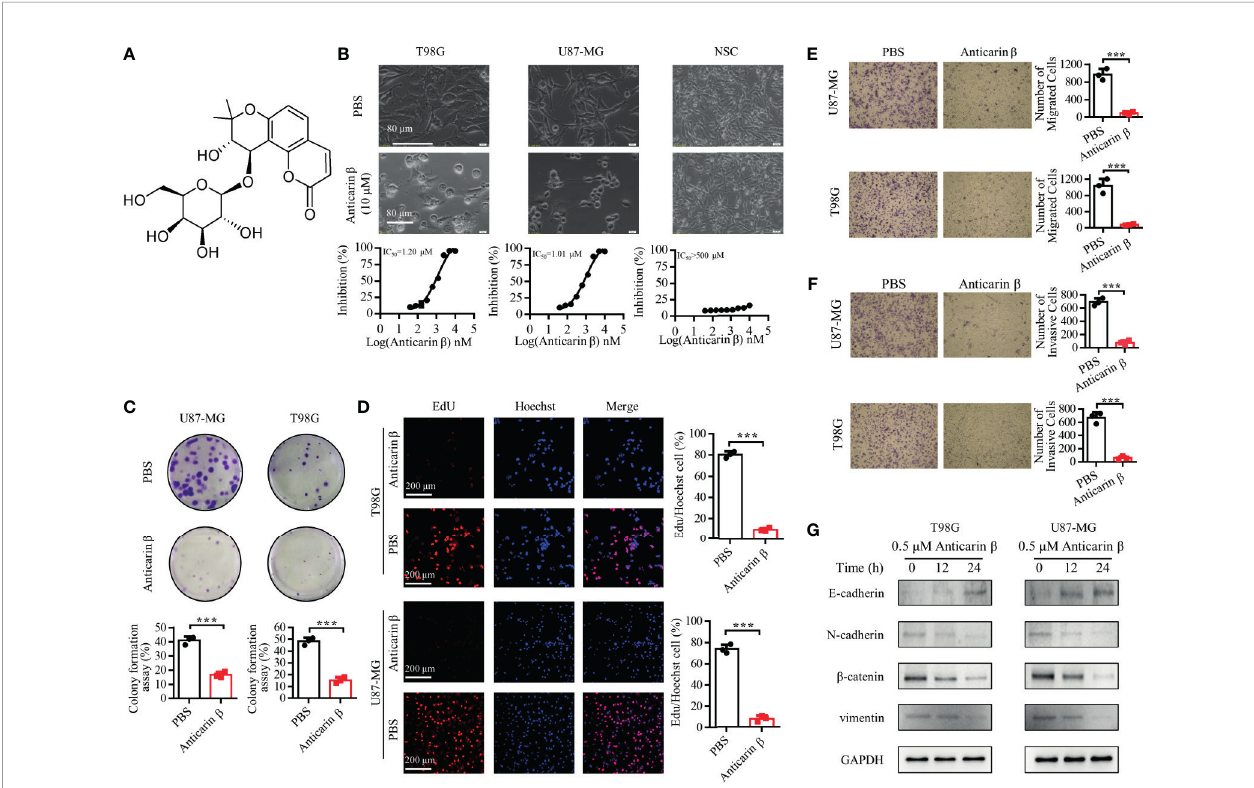
FIGURE 2 | Anticarin b inhibits the proliferation of human glioma cells. (A) The chemical structure of anticarin b . (B) Morphological changes and dose-dependent cytotoxicity on human glioma cell lines (U87-MG and T98G). Cells were treated with 0-10 m M anticarin b for 24h and then observed by phase-contrast microscopy. Cell viability was calculated using MTS analysis. (C) The colony formation results of U87-MG and T98G after treatments of anticarin b (0.5 m M) for 7 days were exhibited. (D) The number of proliferative cells labeled by EdU (red) and cell nucleus labeled by Hoechst 33324 (blue) was different between anticarin b (0.5 m M, 12 hours) and PBS group in U87-MG and T98G. Scale bar, 200 m m. (E) Migration and (F) invasion ability of human glioma cell lines U87-MG and T98G treated with anticarin b (0.5 m M) for 48 hours were measured with transwell migration assay and transwell invasion assay. (G) Western blotting analysis of